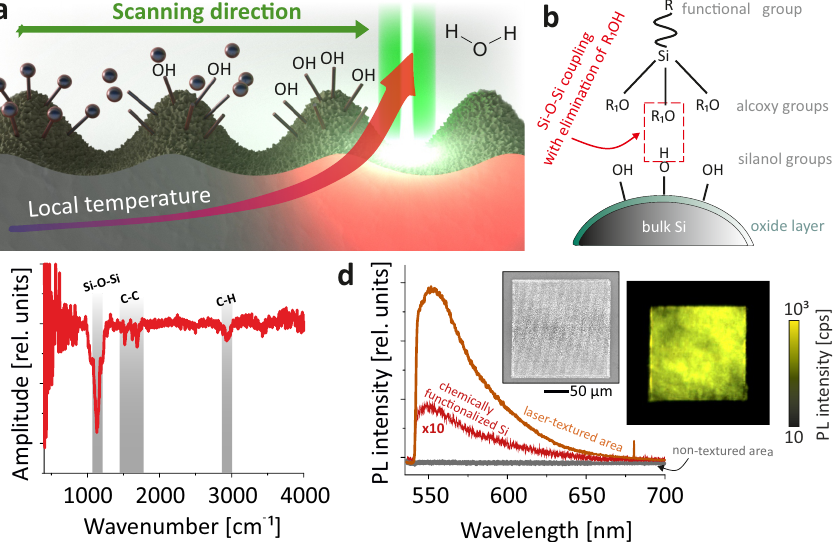
Figure 2. ( a ) Scheme of surface functionalization during fs-laser processing. ( b ) Scheme of surface chemical reaction. ( c ) Normalized FTIR reflection spectrum of the functionalized laser-textured Si surface. ( d ) Averaged PL spectra measured from the laser-textured Si (orange line), non-textured surrounding area (gray line) and chemically functionalized smooth Si (red line). Insets show reference SEM and PL images of a 200 × 200 µ m 2 laser-textured